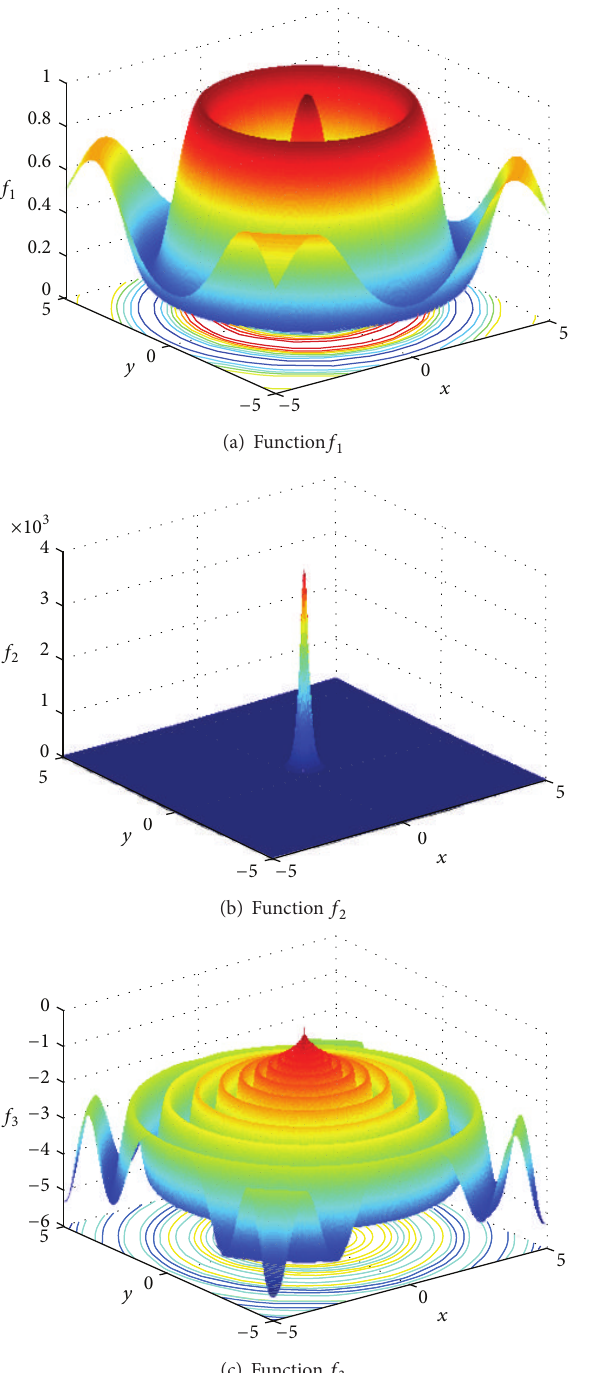
Figure 7: Function diagrams of 𝑓 1 , 𝑓 2 , and 𝑓 3 .